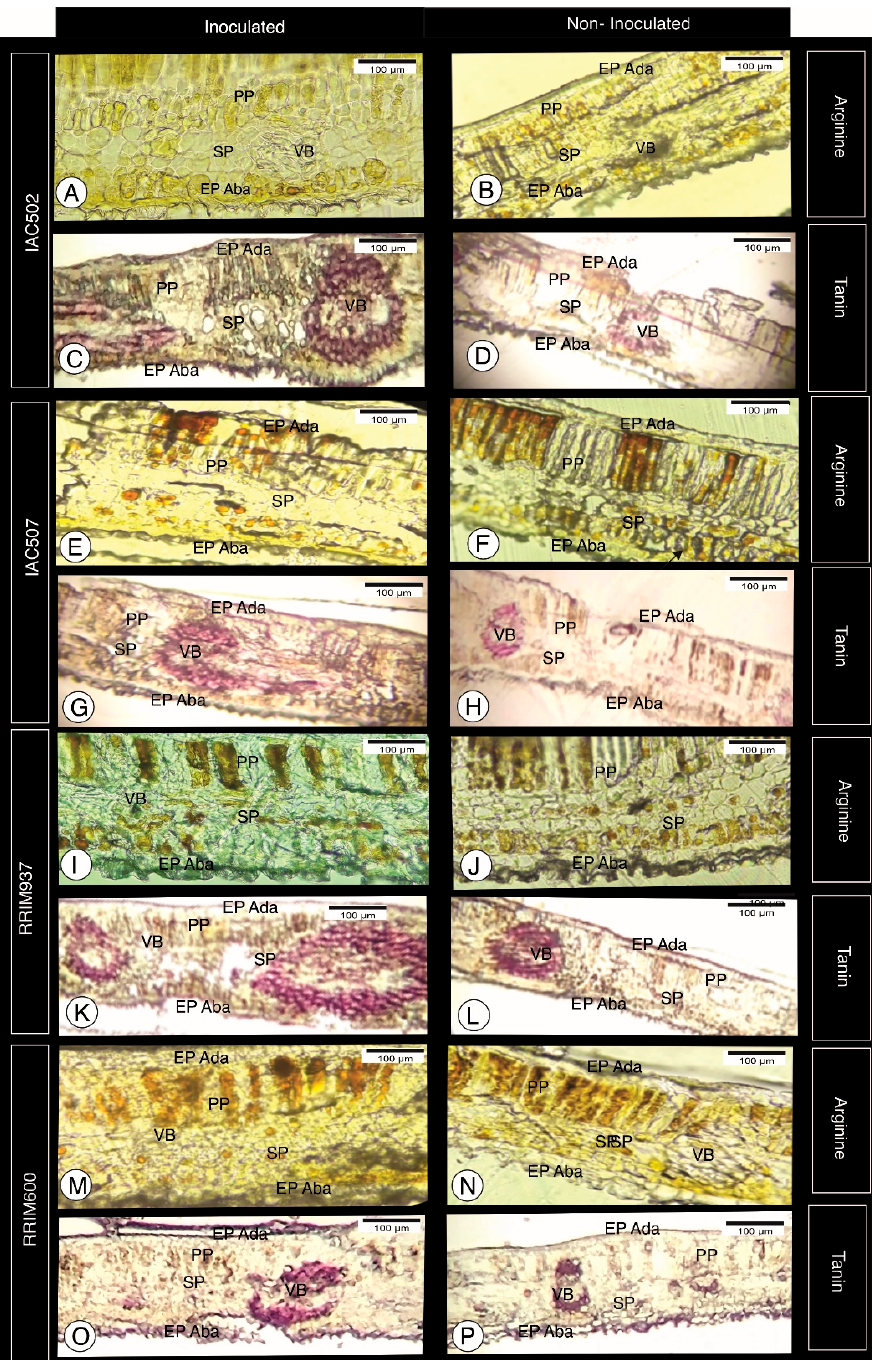
Figure 2. Histological sections stained with α -Naphthol, for arginine visualization (yellow), and vanillin-hydrochloric acid, for tannin visualization (pink), from clones IAC 502 ( A – D ), IAC 507 ( E – H ), RRIM 937 ( I – L ) and RRIM 600 ( M – P ). Inoculated ( left ) and non-inoculated clones ( right ). EPI Ada—Epidermis Adaxial; EPI Aba—Epidemis Abaxial; PP—Palisade Parenchyma; SP—Spongy Parenchyma; VB—Vascular bundle.